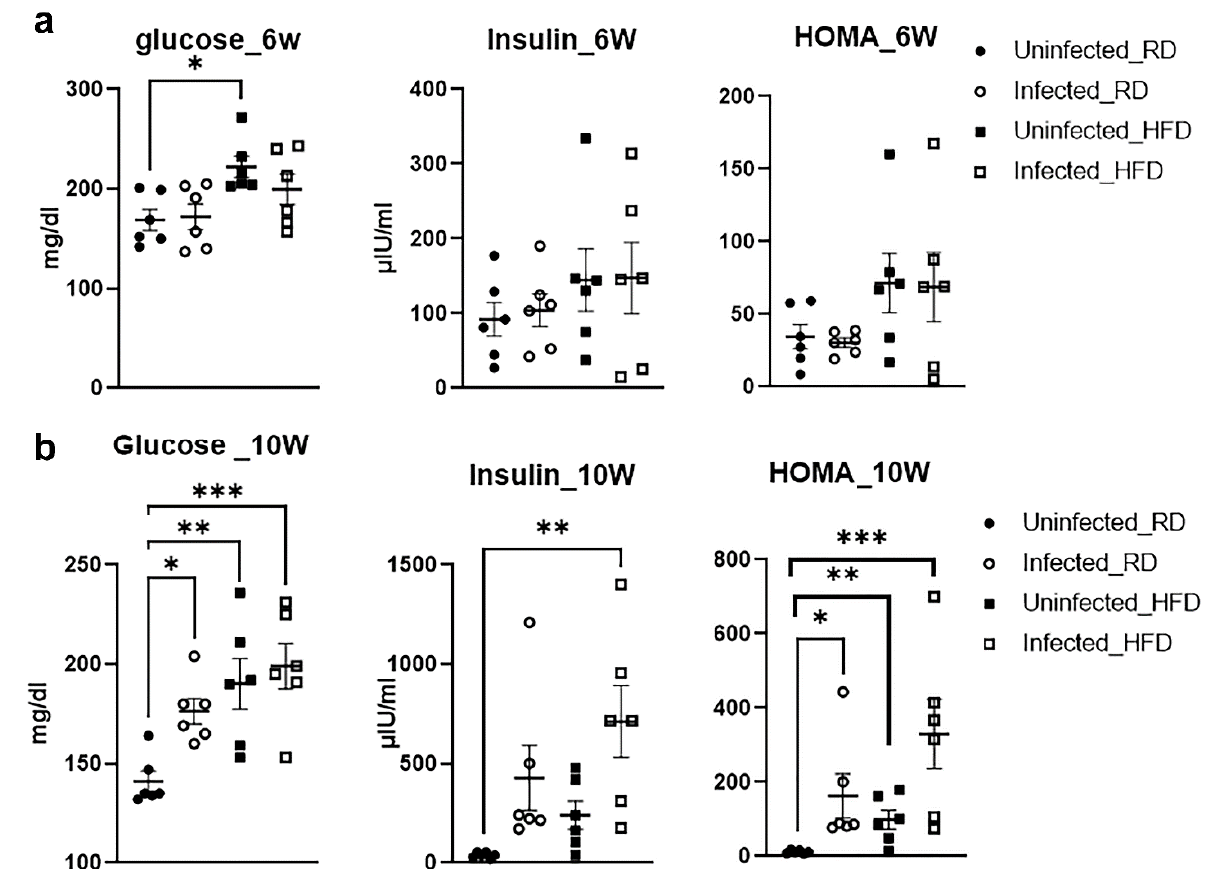
Figure 1. Development of insulin resistance in H37Rv Mtb infected mice (30 DPI) is age dependent ( n = 5/group). ( a ) Serum levels of glucose, insulin and HOMA-IR in juvenile mice measured by ELISA. ( b ) Serum levels of glucose, insulin and HOMA-IR in adult mice measured by ELISA. The error bars represent standard error of the mean. * p < 0.05, ** p < 0.01, and *** p < 0.001, comparison between the indicated groups.